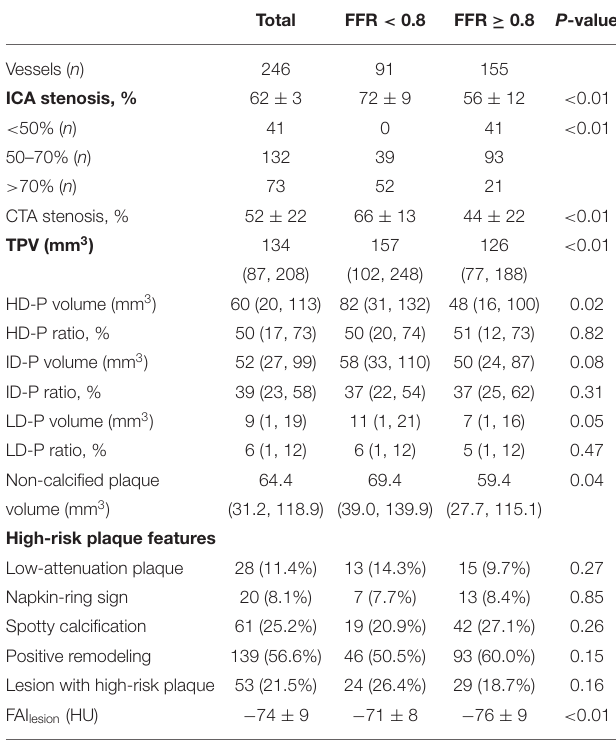
FAI lesion , lesion-specified fat attenuation index; ICA, invasive coronary angiography; CTA, computed tomography angiography; TPV, total plaque volume; HD-P, high- attenuation plaque component; ID-P, intermediate-attenuation plaque component; LD-P, low-attenuation plaque component; HU, Hounsfield